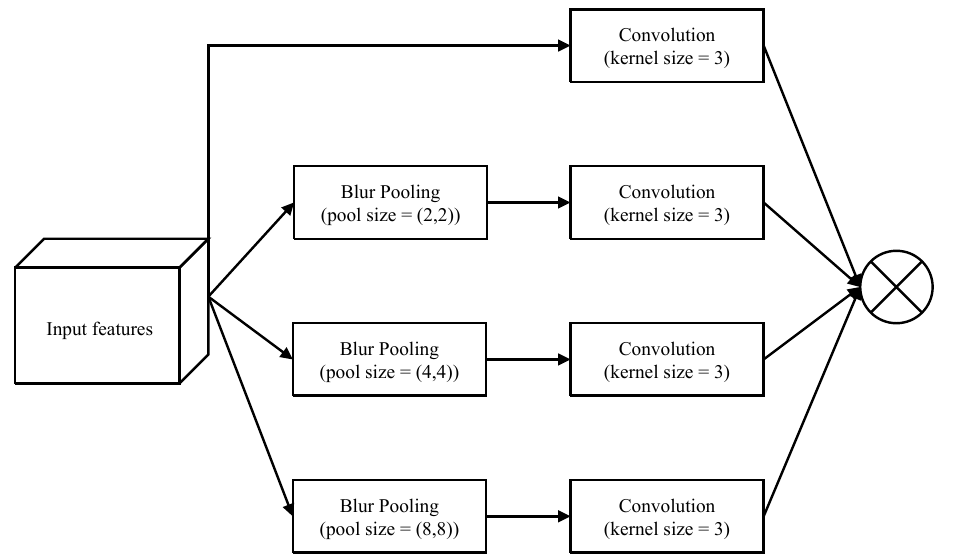
Figure 6. The architecture of the proposed pyramid blur pooling module.